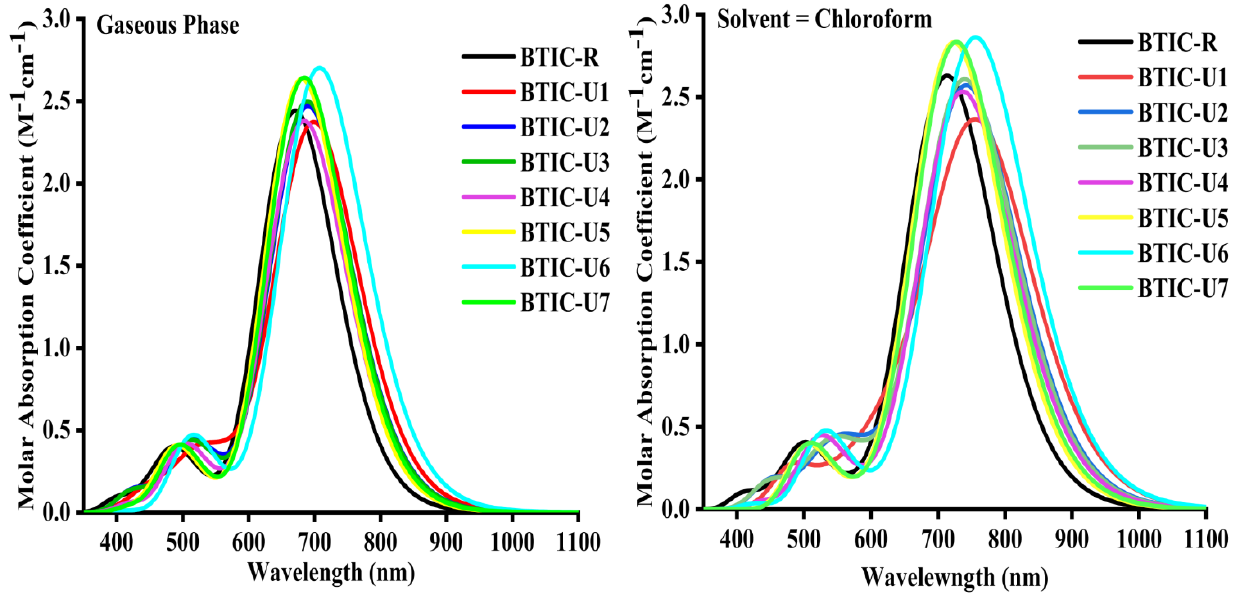
Figure 4. Graphical demonstration of UV–Vis absorption of BTIC − R and BTIC − U1 to BTIC − U7 in Chloroform solvent ( right ) and gaseous phase ( left ).